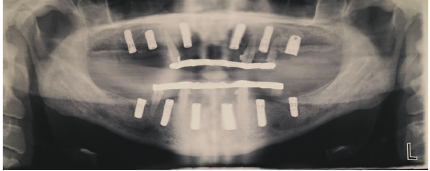
Figure 7: Panoramic radiograph shows the placement of six implants per arch. Note metal-reinforced fixed provisional prosthe- ses retained by retained teeth.